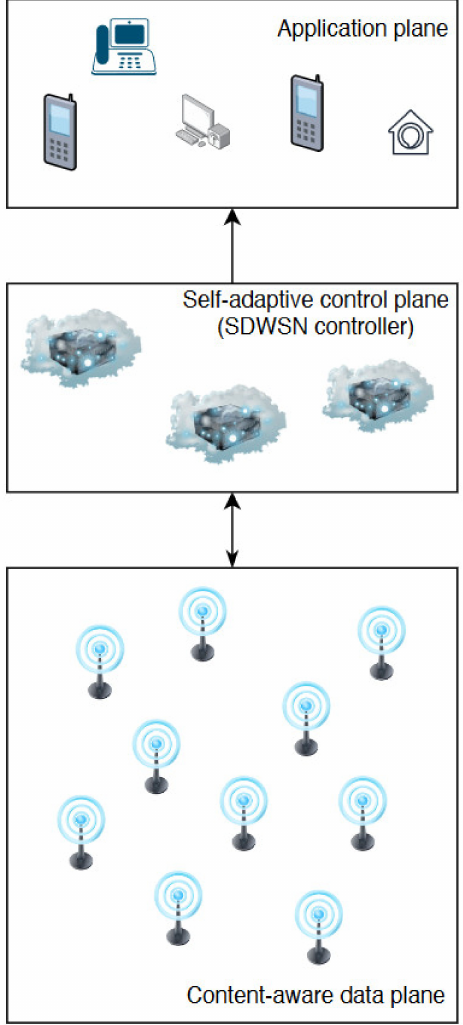
Figure 3. Proposed system